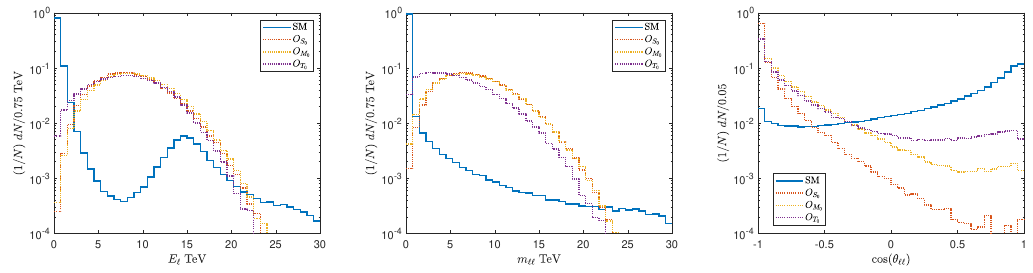
Figure 10 . The normalized distributions of E ‘ (left panel), m ‘‘ (middle panel) and cos( θ ‘‘ ) (right